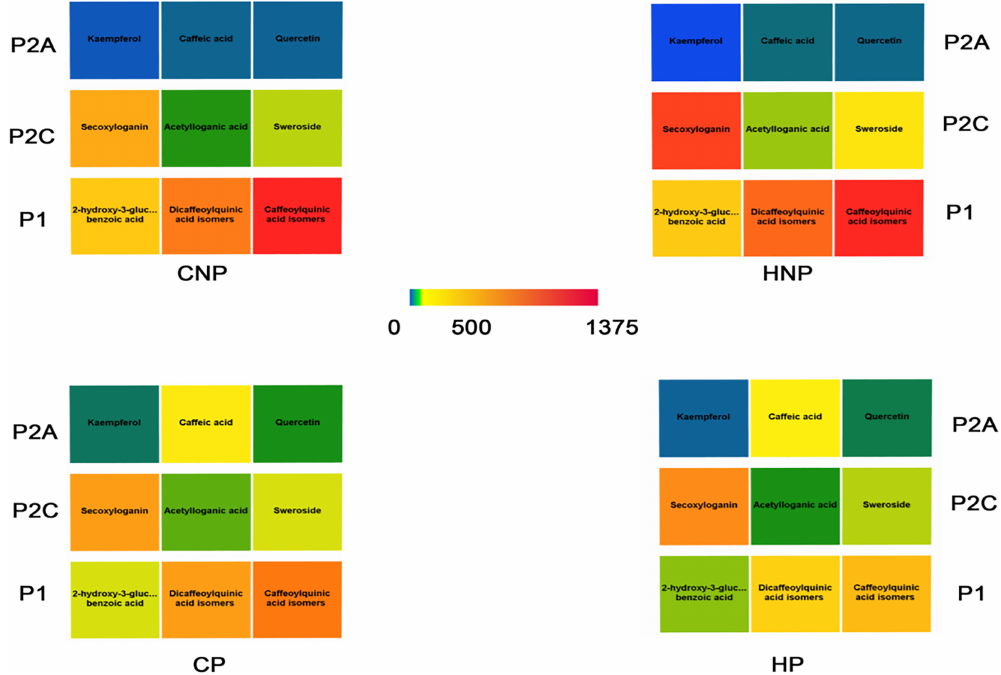
Fig 5. FancyTiles schema for the four extraction methods of Strychnoscocculoides . The values of the scale are reported in μ g/g DW while P2A, P2C and P1 report the clustering highlighted by the dendrogram in Fig 4.